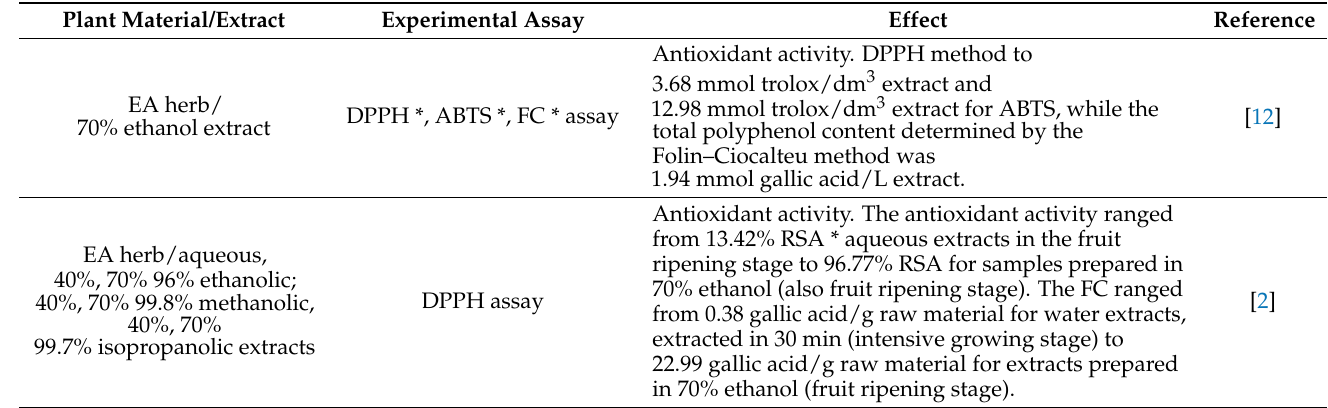
Figure 3. The possible effect of E. angustifolium on skin damage due to oxidative stress occurring. Bioactive compounds contained in E. angustifolium have an antioxidative, anti-inflammatory, anti- aging, as well as antibacterial potential. UV radiation, environmental pollution, smoking, or an incorrect diet may enhance the phenomenon of oxidative stress, which may result in changes in the cells’ structure and function, increase inflammatory processes, mutations, and cancerogenesis, or result in faster skin aging. Table 1. The biological activity of E. angustifolium